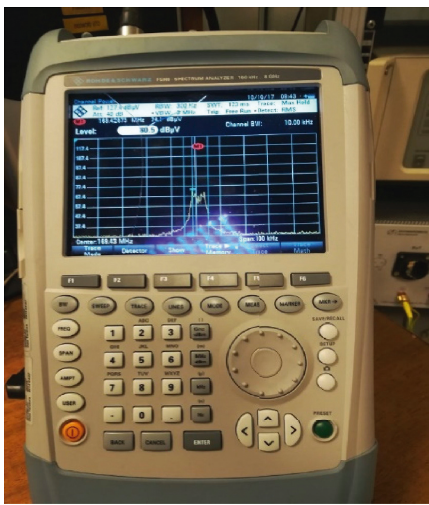
Figure 10: Spectrum analyzer FSH8.